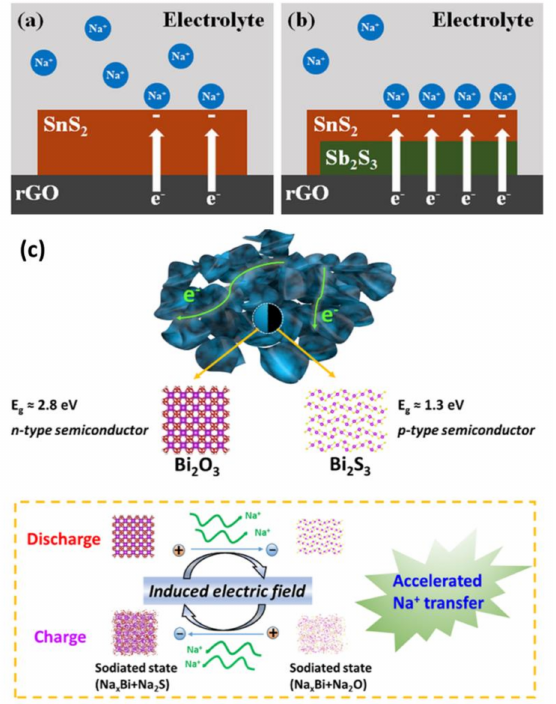
Figure 6. The mechanism of the enhancement of electric conductivity and Na + diffusion kinetics for ( a ) bare SnS 2 and ( b ) SnS 2 /Sb 2 S 3 heterostructure. ( c ) Schematic illustration of the accelerated charge transfer resulted from an induced electric field mechanism in Bi 2 S 3 -Bi 2 O 3